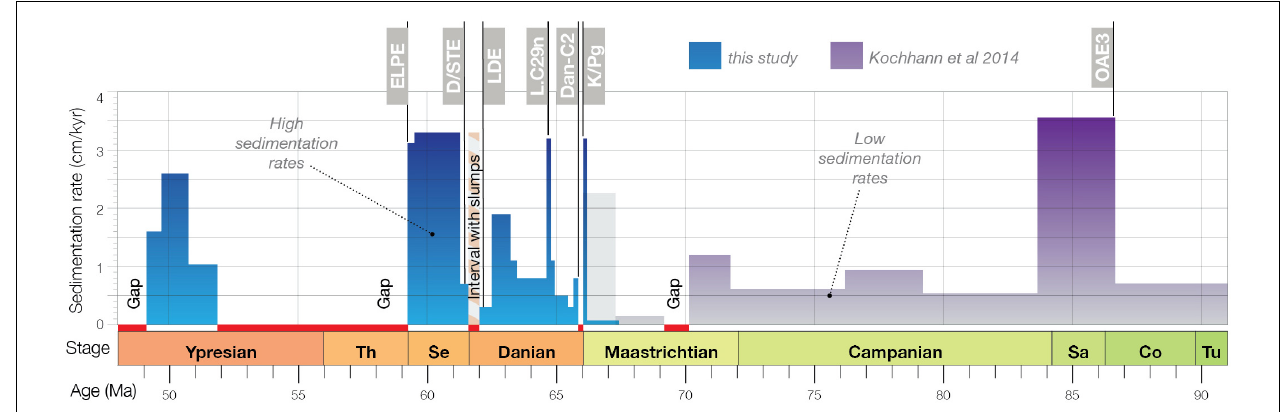
FIGURE 8 | Sedimentary rates for the Sao Paulo Plateau from the late Cretaceous to early Eocene. Blue color indicates values obtained in this study; purple is from Kochhann et al. (2014). Key anomalous intervals are marked and labeled. Sedimentary gaps marked in